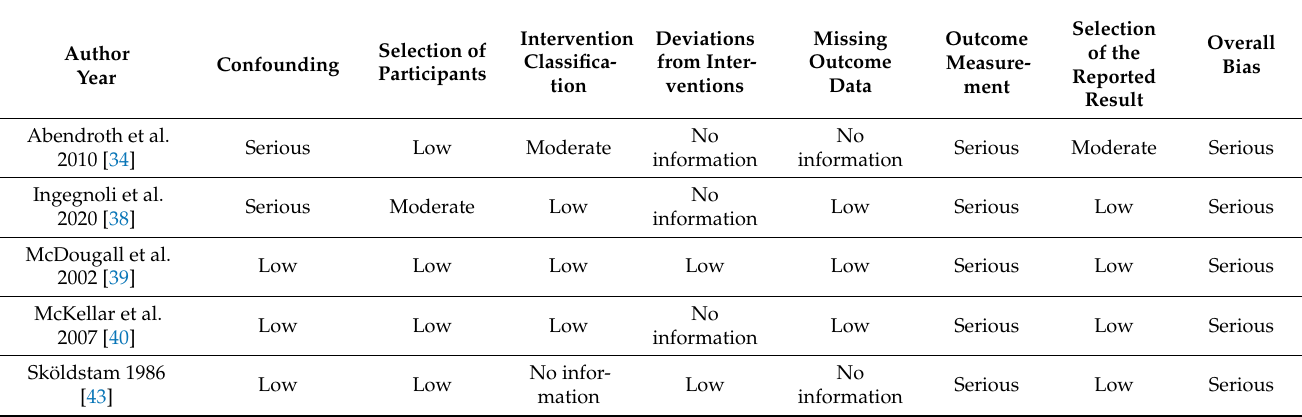
Table 3. Risk of bias assessment of non-randomized studies for the primary outcome